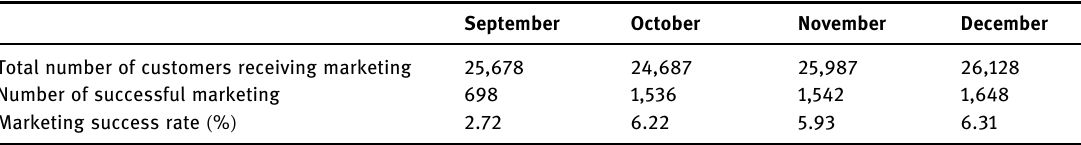
Table 2: Marketing situation of telecommunication enterprise A from September to